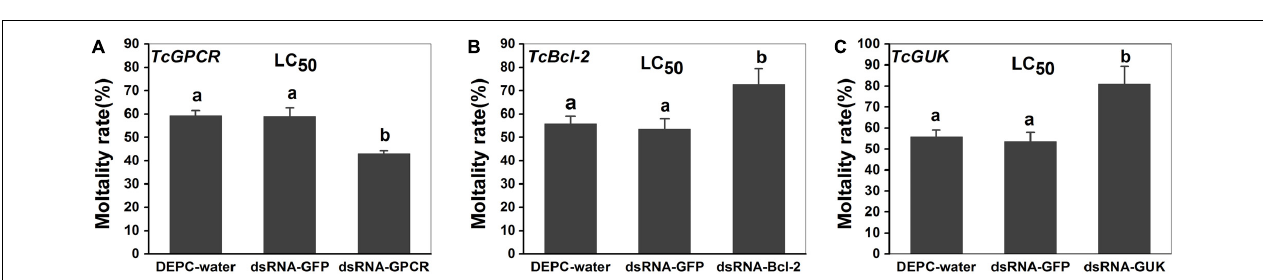
FIGURE 10 | Quantitative PCR expression analysis of TcGPCR, TcBAG, and TcGUK after RNAi at 48 h post-dsRNA feeding, relative to expression levels after DEPC-water treatment, respectively. (A) Expression levels of TcGPCR . (B) Expression levels of TcBAG . (C) Expression levels of TcGUK . Different letters on the error bars indicate significant difference according to Duncan’s multiple tests (alpha = 0.05). i.e., No statistical difference between “a” and “a”; significant difference between “a” and “b.”